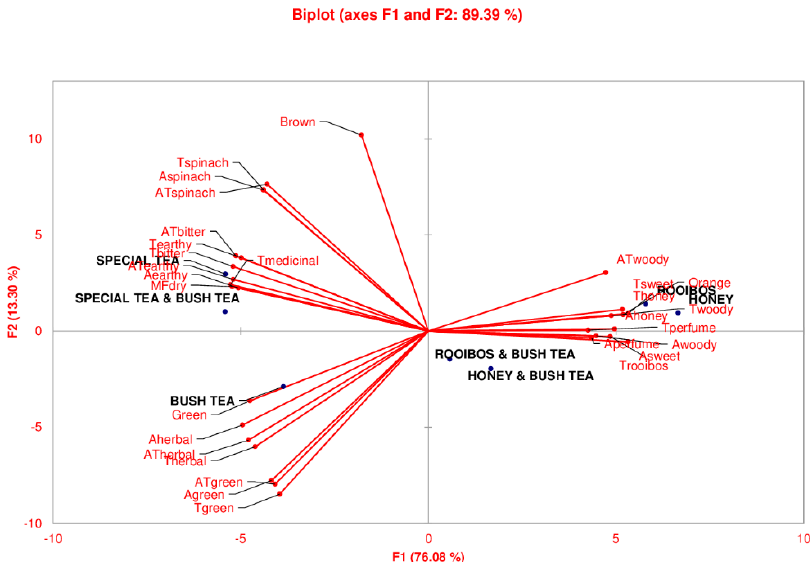
Figure 1. Principal component analysis (PCA) bi-plot showing distinct differences between the tea samples. The letters “A”, “T”, “A” and “MF” in front of an attribute name refer to aroma, taste, aftertaste and mouthfeel attributes,